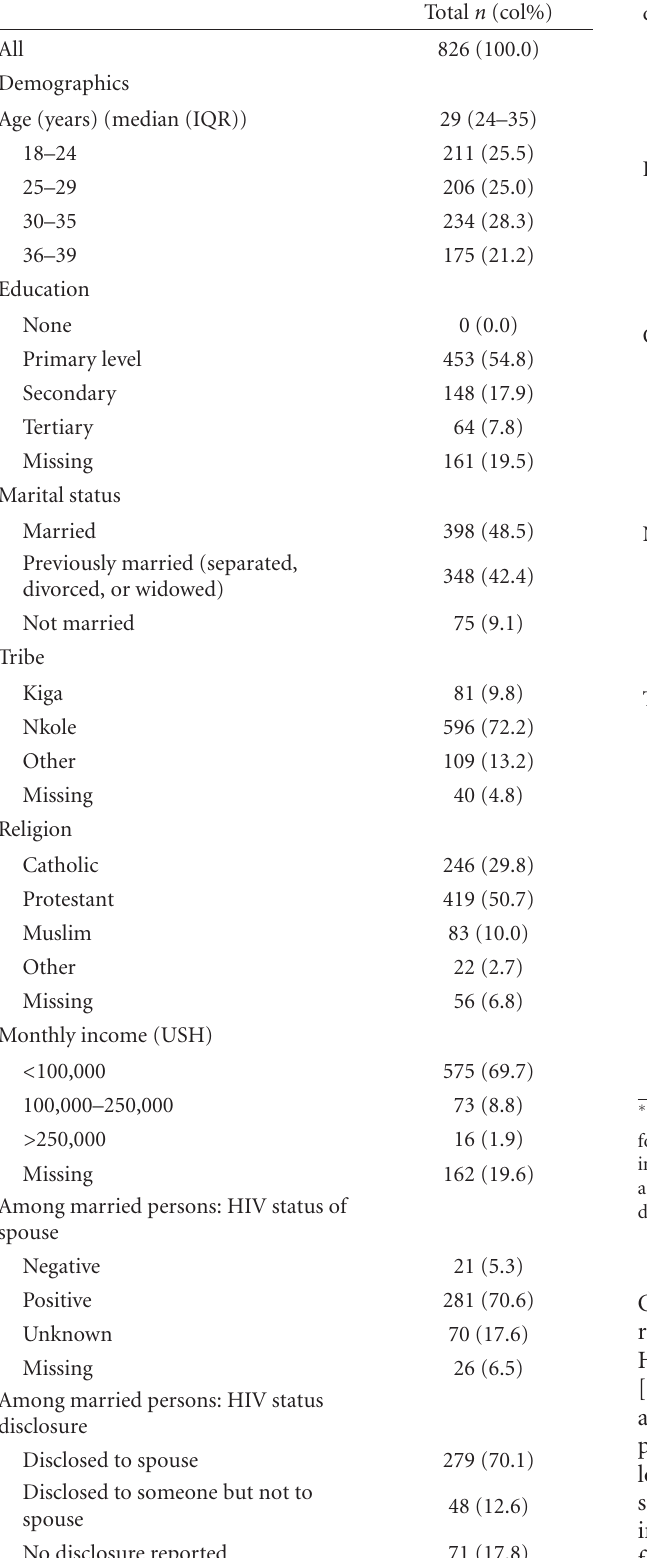
Table 1: Demographic and behavioral characteristics among non- pregnant, sexually active women enrolling at ISS Clinic, Mbarara Uganda, during